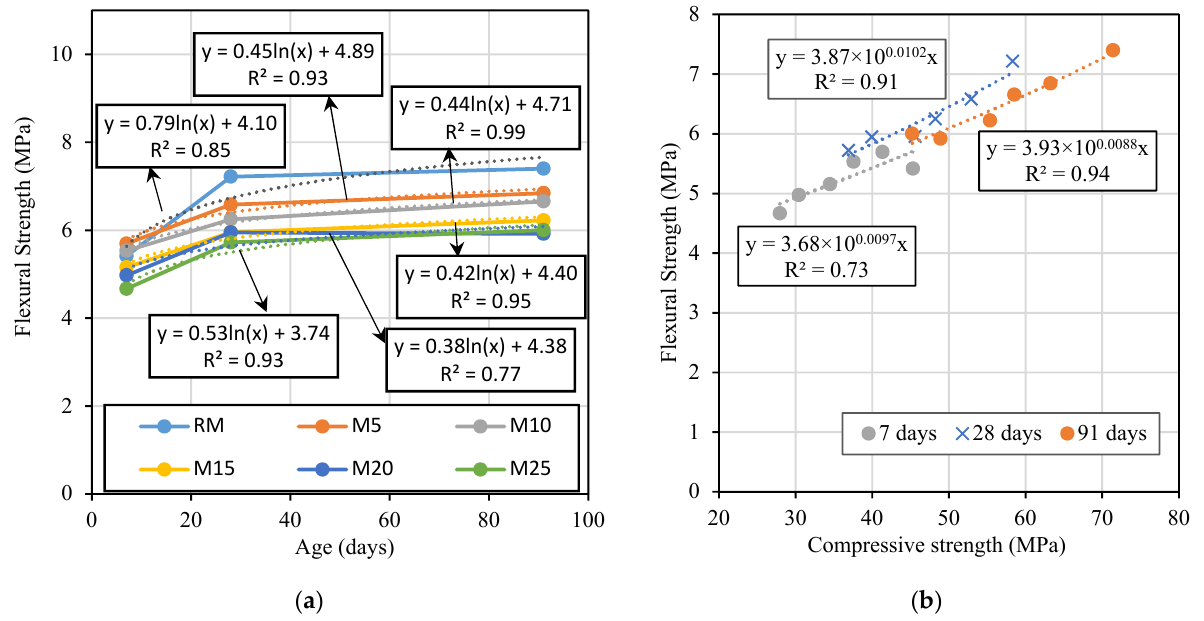
Figure 7. Flexural strength over time in MgO mortars ( a ); relationship between compressive and flexural strength ( b ).